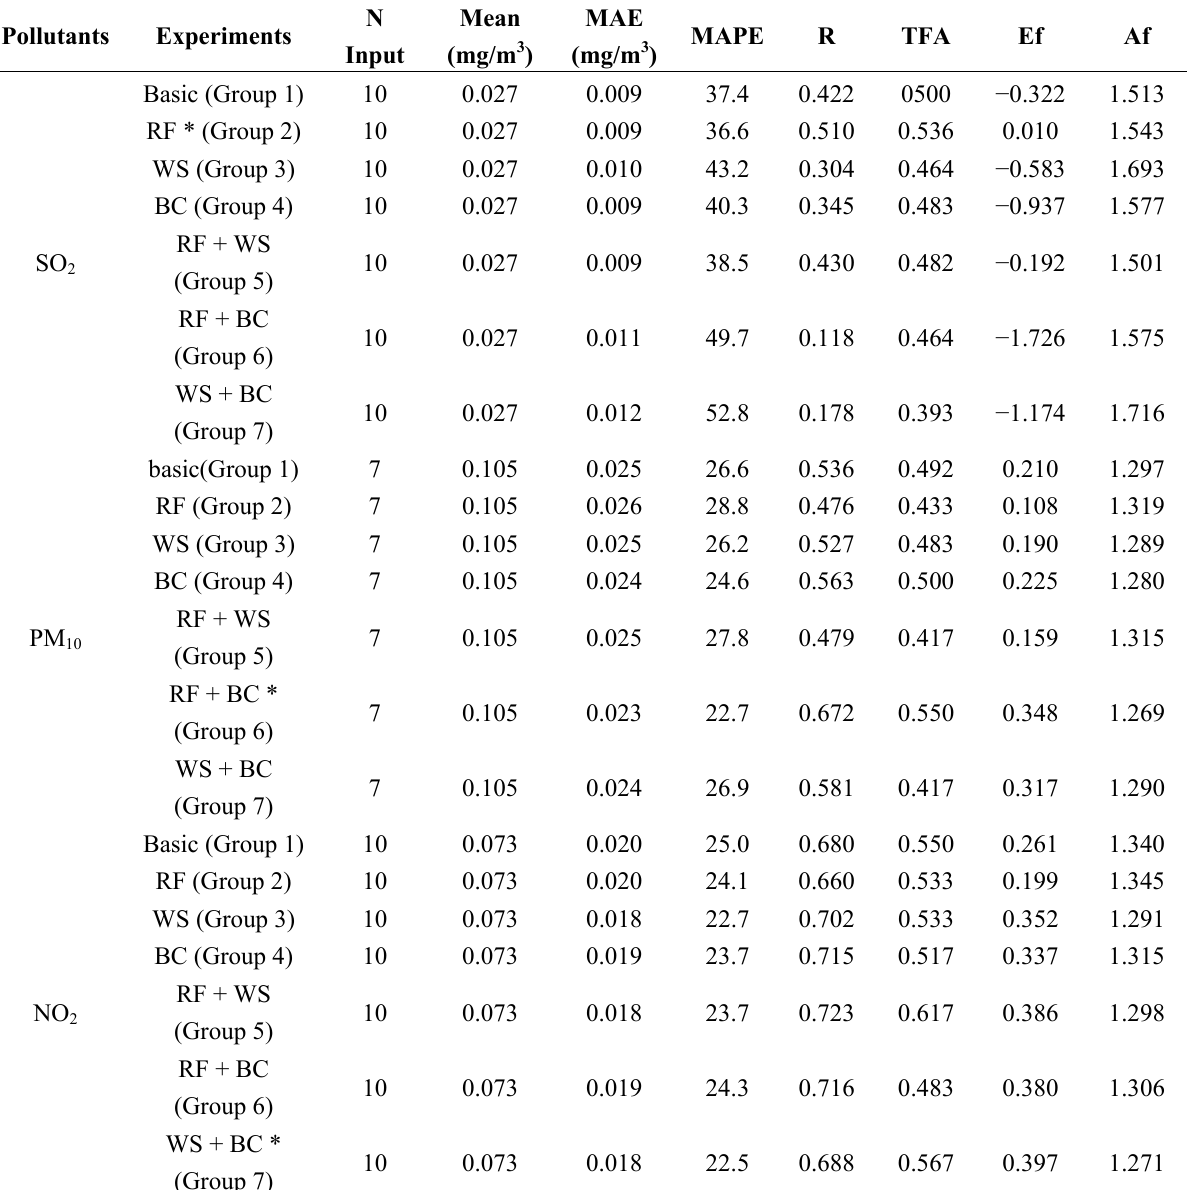
Table 1. Forecasting results of the seven groups of sensitivity